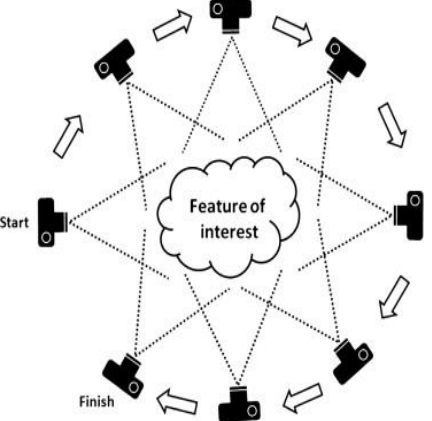
Figure 1: Structure from Motion (SfM). Instead of a single stereo pair, the SFM technique requires multiple overlapping photos as input for feature extraction and 3D reconstruction